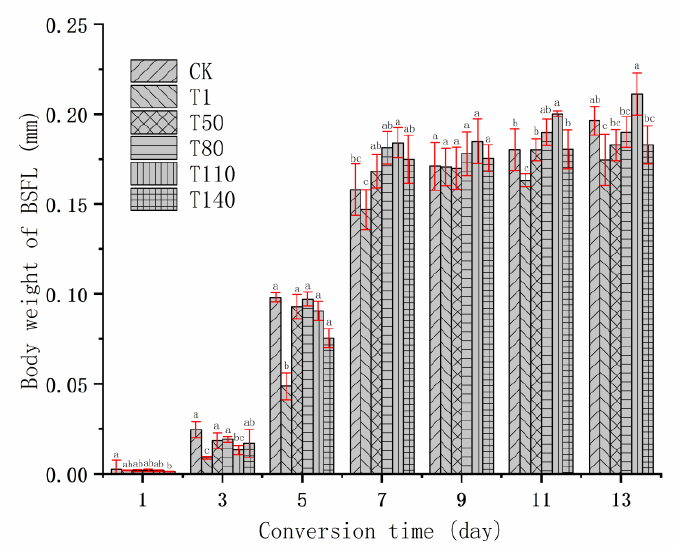
Figure 3. Trend of body weight of BSFL. Note: The different lowercase letters indicate significant differences among treatments ( p < 0.05). Table 4. Effect of adding DKW on the body components of the Table 3. Effect of the amount of DKW on the growth and development of the BSFL.